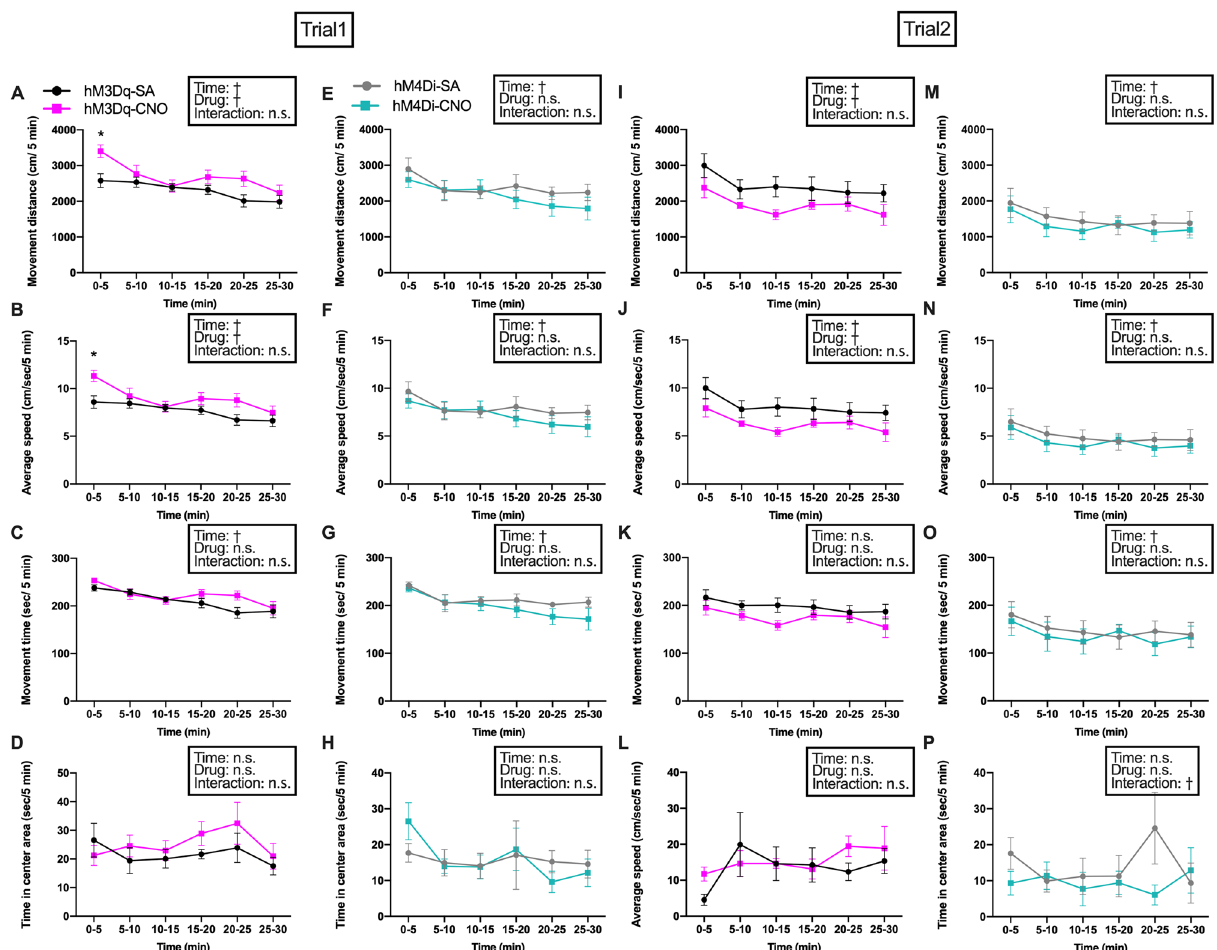
Figure 2. Enhanced locomotor activity in the open field (OF) by chemogenetic HA TMN neuron activation depended on environmental novelty. Locomotor parameters were compared in the OF among Hdc-hM3Dq mice (n = 6, A ‒ D , I ‒ L ) and Hdc-hM4Di mice (n = 5, E ‒ H , M ‒ P ) for 30 min after CNO or SA injection by two-way RM ANOVA with main factors trial number ( A ‒ H : novel OF in trial 1, I ‒ P : non-novel OF in trial 2) and drug treatment (CNO or SA), followed by Sidak’s post hoc tests. ( A ) Total movement distance of Hdc-hM3Dq mice after CNO or SA injection during trial 1 (time: F = 7.48, P < 0.0001, drug: F = 5.77, P = 0.037, trial × drug interaction: F = 1.70, P = 0.15). ( B ) Average speed of Hdc-hM3Dq mice after CNO or SA injection during trial 1 (time: F = 7.48, P < 0.0001; drug: F = 5.77, P = 0.037; interaction: F = 1.70, P = 0.15). ( C ) Total movement time of Hdc-hM3Dq mice after CNO or SA injection during trial 1 (time: F = 8.77, P < 0.0001; drug: F = 2.91, P = 0.12; interaction: F = 1.46, P = 0.22). ( D ) Time spent in the central area by Hdc-hM3Dq mice after CNO or SA injection during trial 1 (time: F = 1.27, P = 0.29; drug: F = 1.02, P = 0.34; interaction: F = 0.77, P = 0.58). ( E ) Total movement distance of Hdc-hM4Di mice after CNO or SA injection during trial 1 (time: F = 9.92, P < 0.0001; drug: F = 0.46, P = 0.52; interaction: F = 1.80, P = 0.14). ( F ) Average speed of Hdc-hM4Di mice after CNO or SA injection during trial 1 (time: F = 9.96, P < 0.0001; drug: F = 0.46, P = 0.52; interaction: F = 1.80, P = 0.13). ( G ) Total movement time of Hdc-hM4Di mice after CNO or SA injection during trial 1 (time: F = 10.54, P < 0.0001; drug: F = 0.84, P = 0.39; interaction: F = 1.52, P = 0.21). ( H ) Time spent in the central area by Hdc-hM4Di mice after CNO or SA injection during trial 1 (time: F = 1.94, P = 0.11; drug: F = 0.0017, P = 0.97; interaction: F = 0.87, P = 0.51). ( I ) Total movement distance of Hdc-hM3Dq mice after CNO or SA injection during trial 2 (time: F = 3.44, P = 0.0096; drug: F = 5.05, P = 0.048; interaction: F = 0.31, P = 0.90). ( J ) Average speed of Hdc-hM3Dq mice after CNO or SA injection during trial 2 (time: F = 3.44, P = 0.0096; drug: F = 5.05, P = 0.048; interaction F = 0.31, P = 0.90). ( K ) Total movement time of Hdc-hM3Dq mice after CNO or SA injection during trial 2 (time: F = 2.05, P = 0.88; drug: F = 3.43, P = 0.094; interaction: F = 0.51, P = 0.77). L, Time spent in the centre area by Hdc-hM3Dq mice after CNO or SA injection during trial 2 (time: F = 2.22, P = 0.070; drug: F = 0.20, P = 0.67; interaction: F = 1.15, P = 0.35). ( M ) Total movement distance of Hdc-hM4Di mice after CNO or SA injection during trial 2 (time: F = 7.38, P < 0.0001; drug: F = 0.26, P = 0.62; interaction: F = 0.63, P = 0.68). ( N ) Average speed of Hdc-hM4Di mice after CNO or SA injection during trial 2 (time: F = 7.38, P < 0.0001, drug: F = 0.26, P = 0.62, interaction: F = 0.63, P = 0.68). ( O ) Total movement time of Hdc-hM4Di mice after CNO or SA injection during trial 2 (time: F = 5.98, P = 0.0003; drug: F = 0.12, P = 0.74; interaction: F = 1.27, P = 0.30). ( P ) Time spent in the centre area by Hdc-hM4Di mice after CNO or SA injection during trial 2 (time: F = 1.06, P = 0.40; drug: F = 0.54, P = 0.49; interaction: F = 3.45, P = 0.011). Data presented as mean ± S.E. † P < 0.05 by two-way RM ANOVA for ‘time’ and ‘drug’, * P < 0.05 by post hoc Sidak’s multiple comparisons